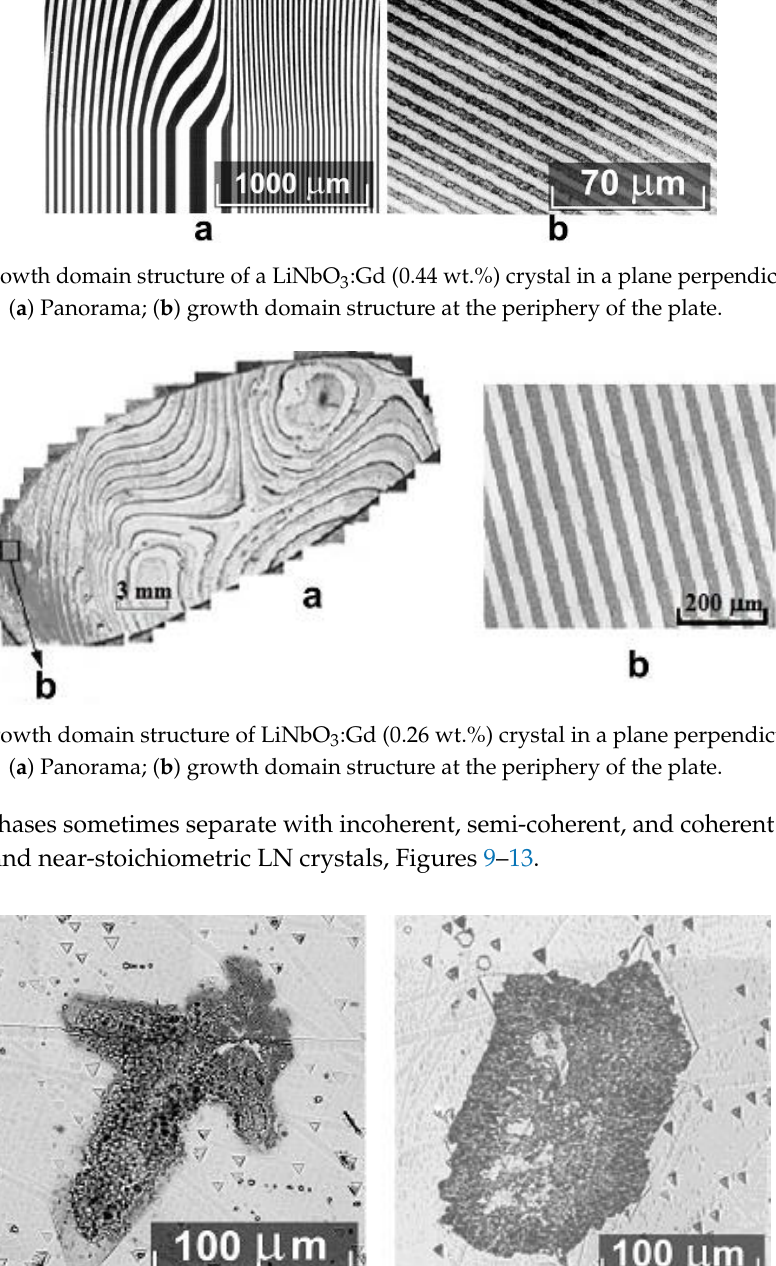
Figure 9. Separation of the second phase with incoherent boundaries: ( a ) crystal LiNbO 3 :Mg ([MgO] = 5.0 mol.% in the melt); ( b ) crystal LiNbO 3 :Zn ([ZnO] ≈ 3.95 mol.% in a crystal) . Z-cut.